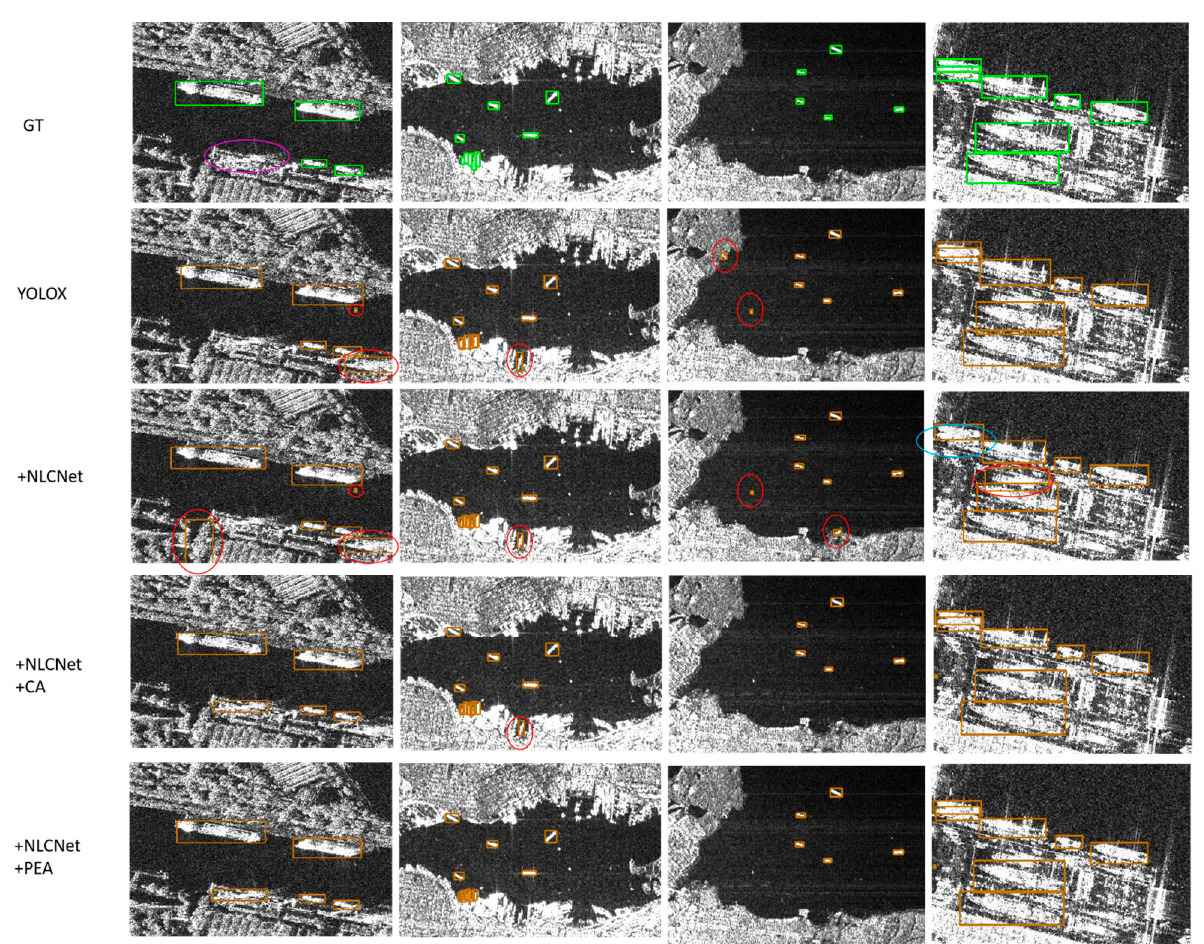
Table 3. Results of ablation experiments. (mAP, FLOPs, Params and average inference time represent detection accuracy, computational complexity, parameter amount and average inference time, respectively).